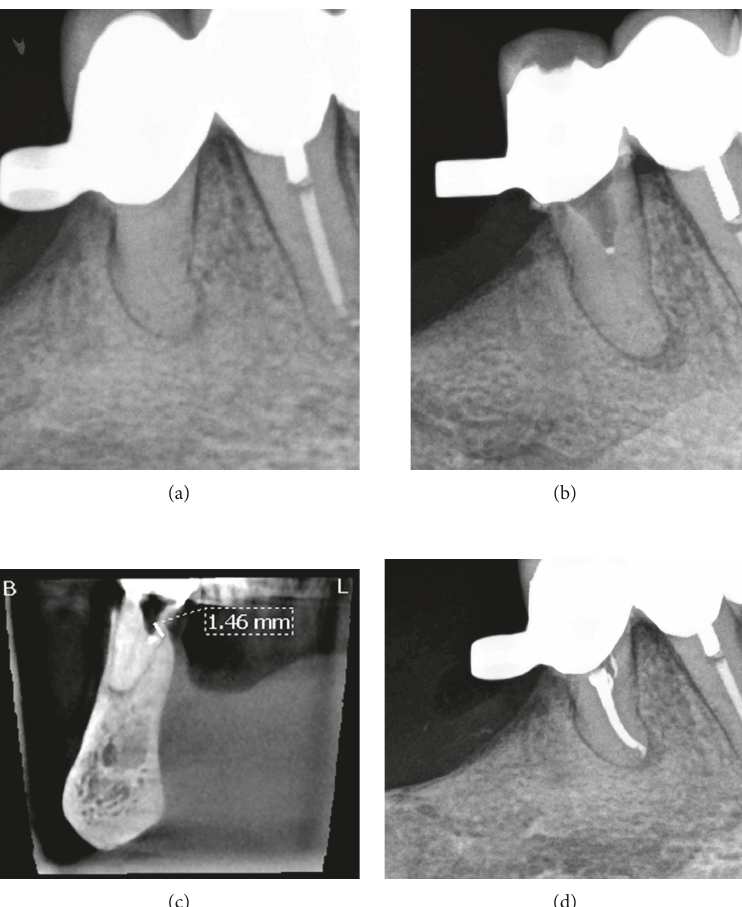
Figure 1: Treatment sequence of tooth 45. (a) Preoperative radiograph. (b) Intraoperative radiograph with gutta-percha point. (c) Coronal view of intraoperative CBCT with gutta-percha point. (d) Postoperative